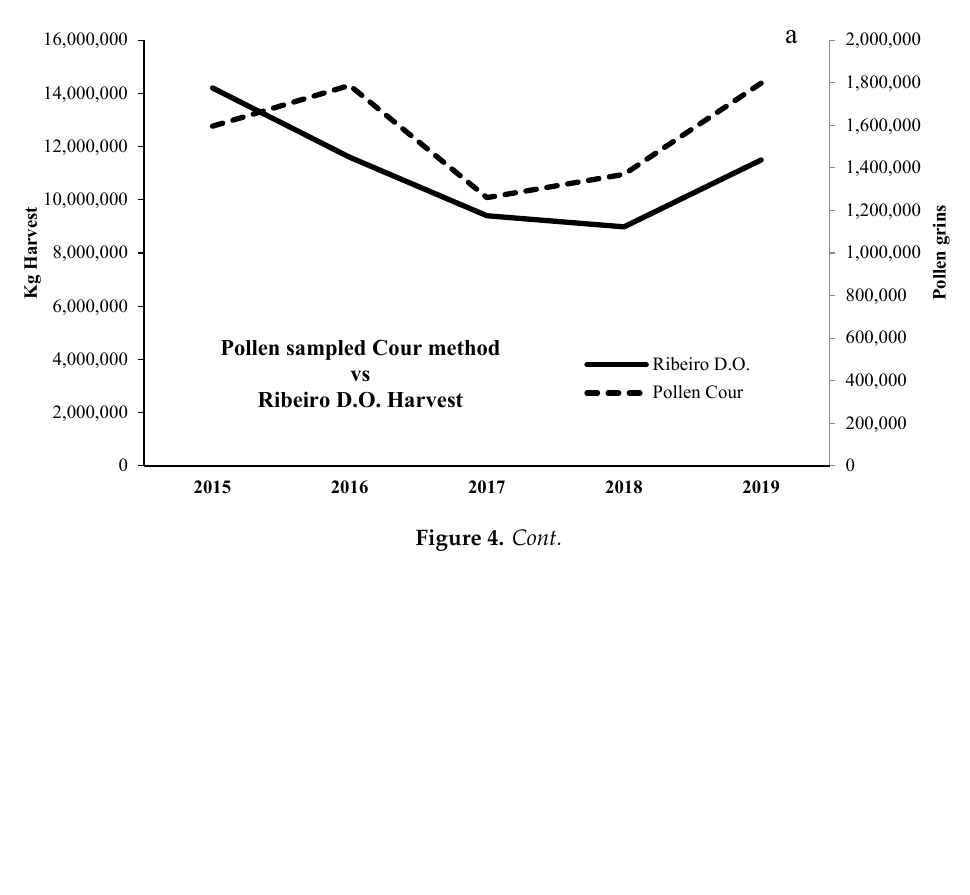
Table 3. Spearman correlation between Hirst and Cour pollen traps and main meteorological variables, during the main pollen season (MPS) and during pre ‐ peak (** p ≤ 0.01; * p ≤ 0.05).